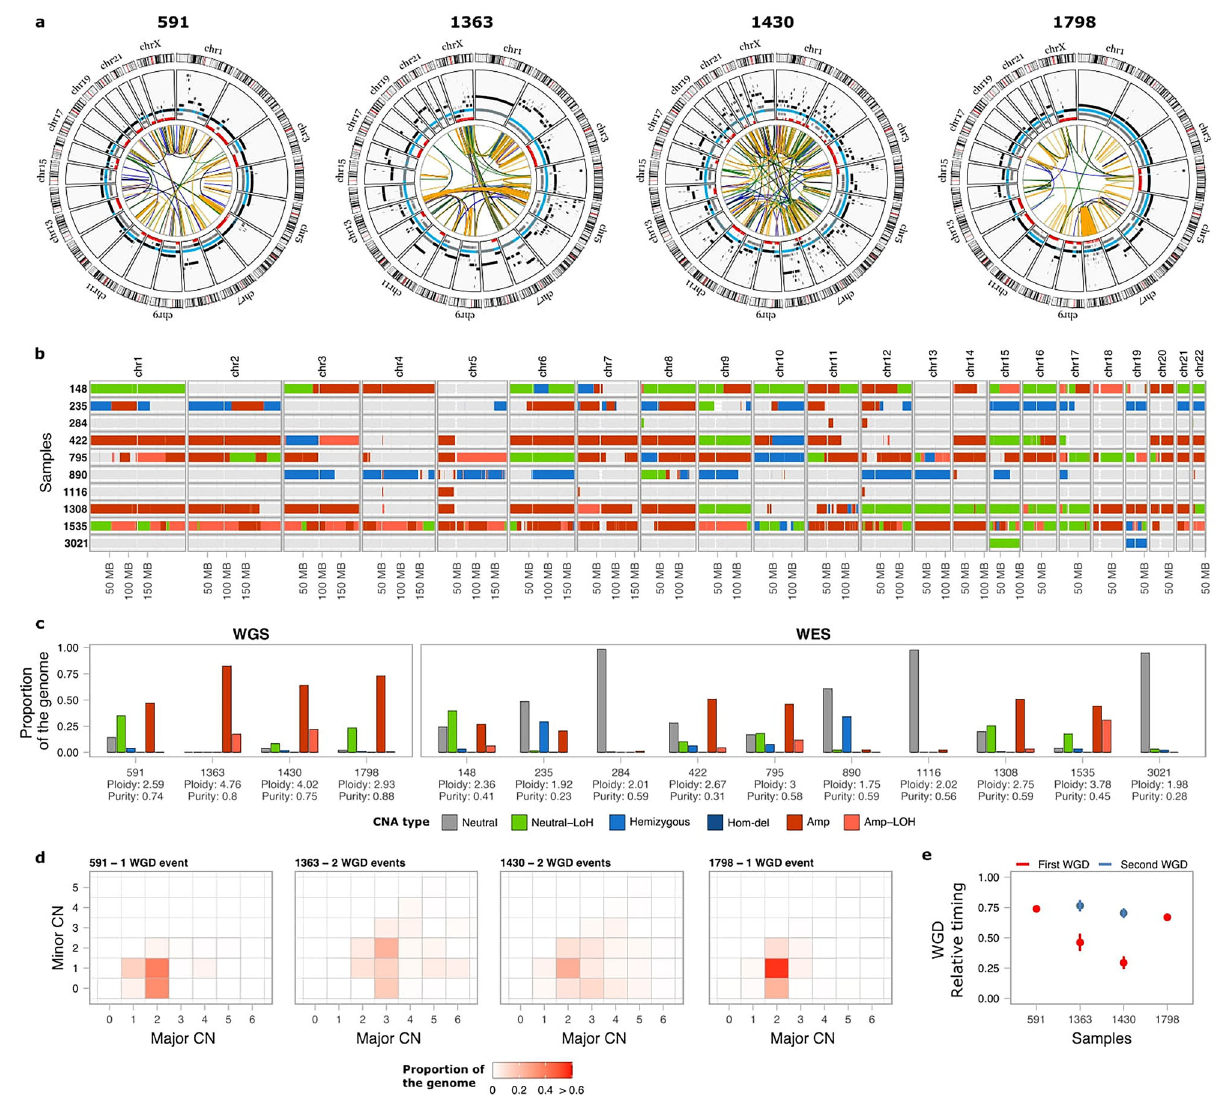
Fig. 7 Somatic genomic landscape of 14 OS/PDB patients. a Circos plots for 4 OS/PDB patients analysed using whole-genome sequencing. The inner circle shows somatic SVs coloured according to the type of SV (duplication-like, deletion-like, head-to-head and tail-to-tail inversions are shown in blue, orange, black and green, respectively). The second circle shows SCNAs, with black representing the total copy number, grey the minor copy number, and red the minor copy number when equal to 0. Blue segments mark the expected normal diploid state (CN = 2) as a reference for visualisation. b SCNA calls for the 10 WES OS/PDB patients. The colour of the bars represents the different types of SCNAs. c Proportion of the genome affected by each type of SCNA. d Heatmap of the proportion of the genome representing the different combinations of the obtained major and minor copy numbers in the WGS samples used to estimate the number of WGD events. e Relative timing analysis of the WGD events for the WGS samples. The colour of the dots represents the fi rst (red) and second (blue) WGS events for each sample. Lines represent the 95% con fi dence intervals after bootstrapping 1000 times. Neutral: total copy number = 2 and minor copy number = 1; Neutral-LoH: total copy number = 2 and minor copy number = 0; Hemizygous: total copy number = 1; Hom-del: homozygous deletion; Amp-LoH: total copy number > 2 and minor copy number =